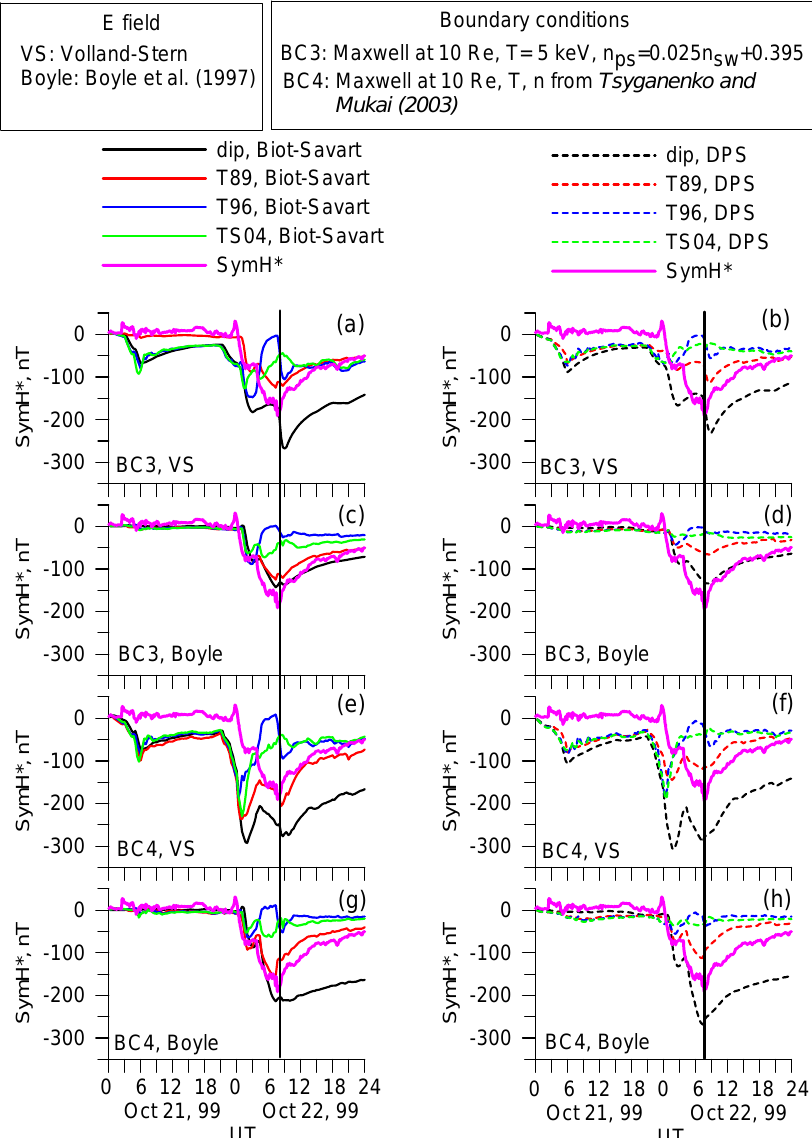
Fig. 11. Similar to Fig. 9 but for 21–22 October 1999 storm.